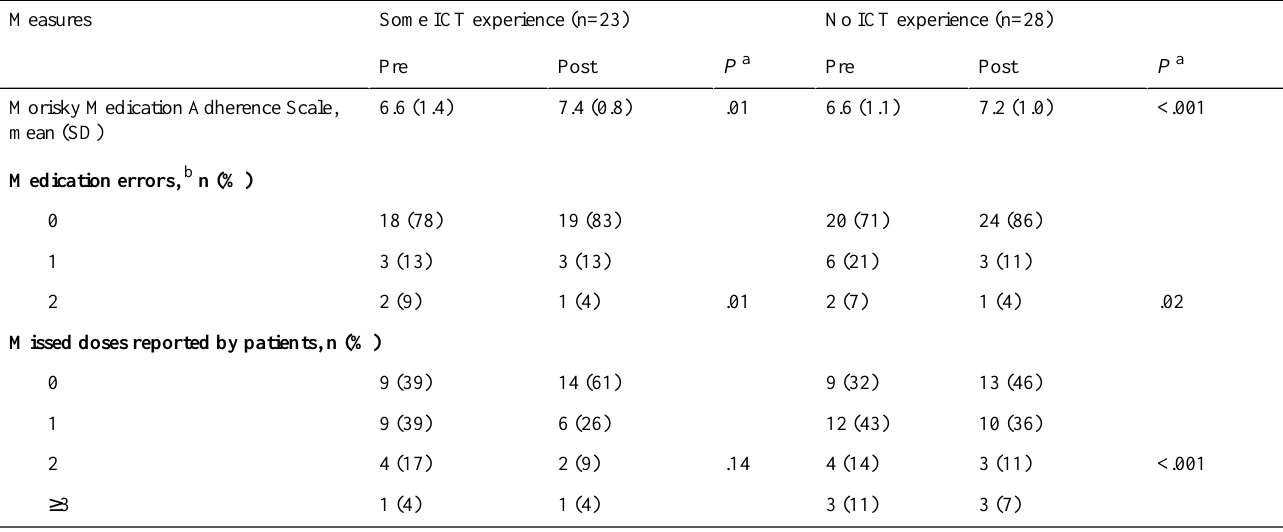
Table 3. Influence of ALICE and patients’ previous experience with information and communication technology (ICT) in the experimental group (n=51).